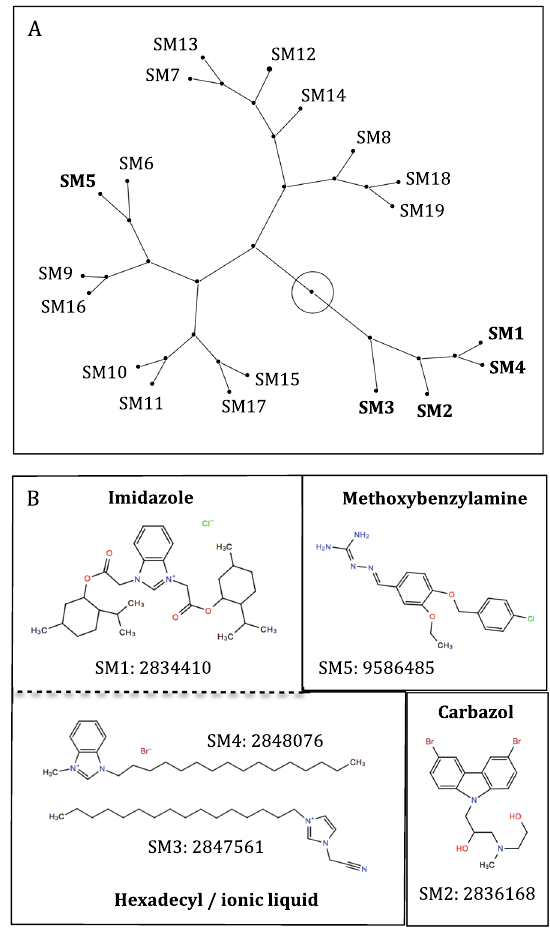
Figure 2. Structural analysis of the 19 small molecules (SMs) that completely inhibited Salomella enterica subsp. enterica serotype Typhimurium growth. ( A ) Constellation plot of the selected 19 SMs based on their two- dimensional structural similarities. In bold: SMs effective against nine Salmonella serovars. The root of the tree is represented by the circle within the plot. ( B ) Skeletal chemical formula of the selected five SMs. SMs were clustered based on the main chemical group with estimated antimicrobial properties. Serial number: PubChem